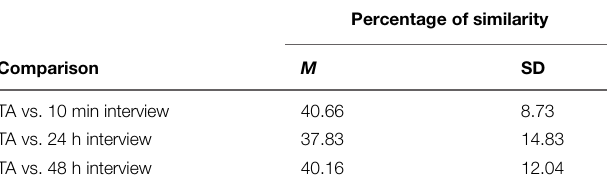
TABLE 7 | Percentage similarity in themes identified during TA and at